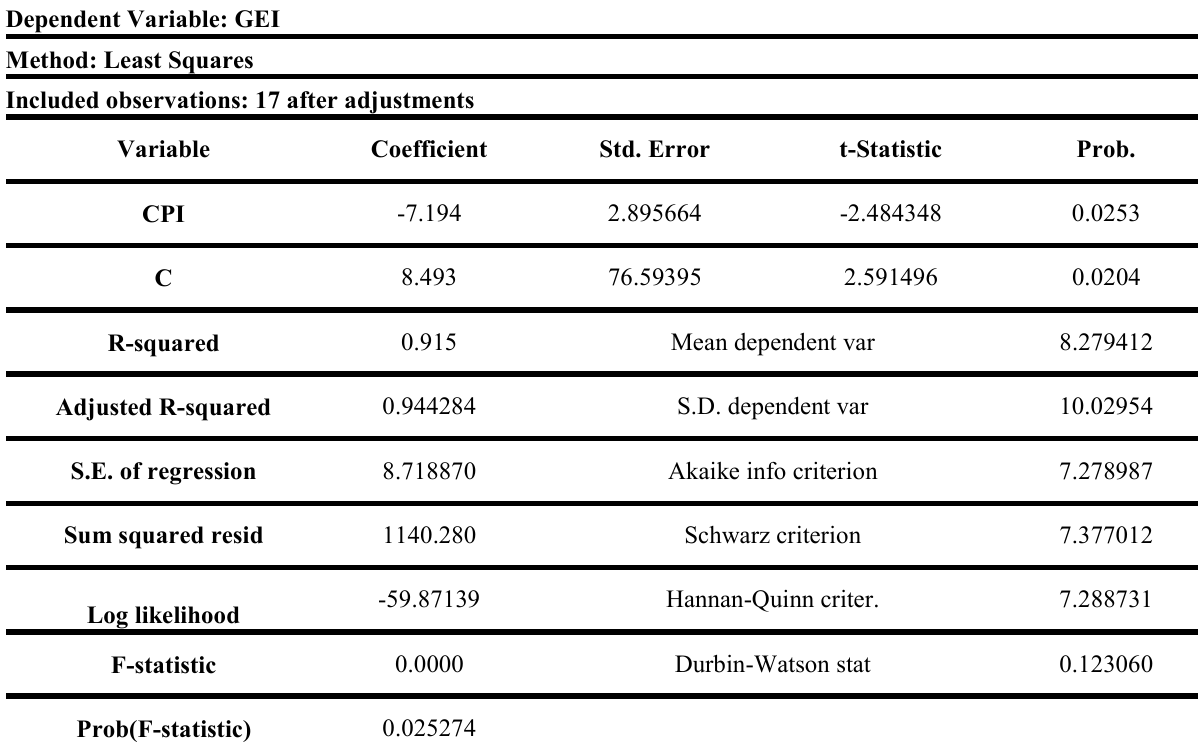
Table.3: Regression